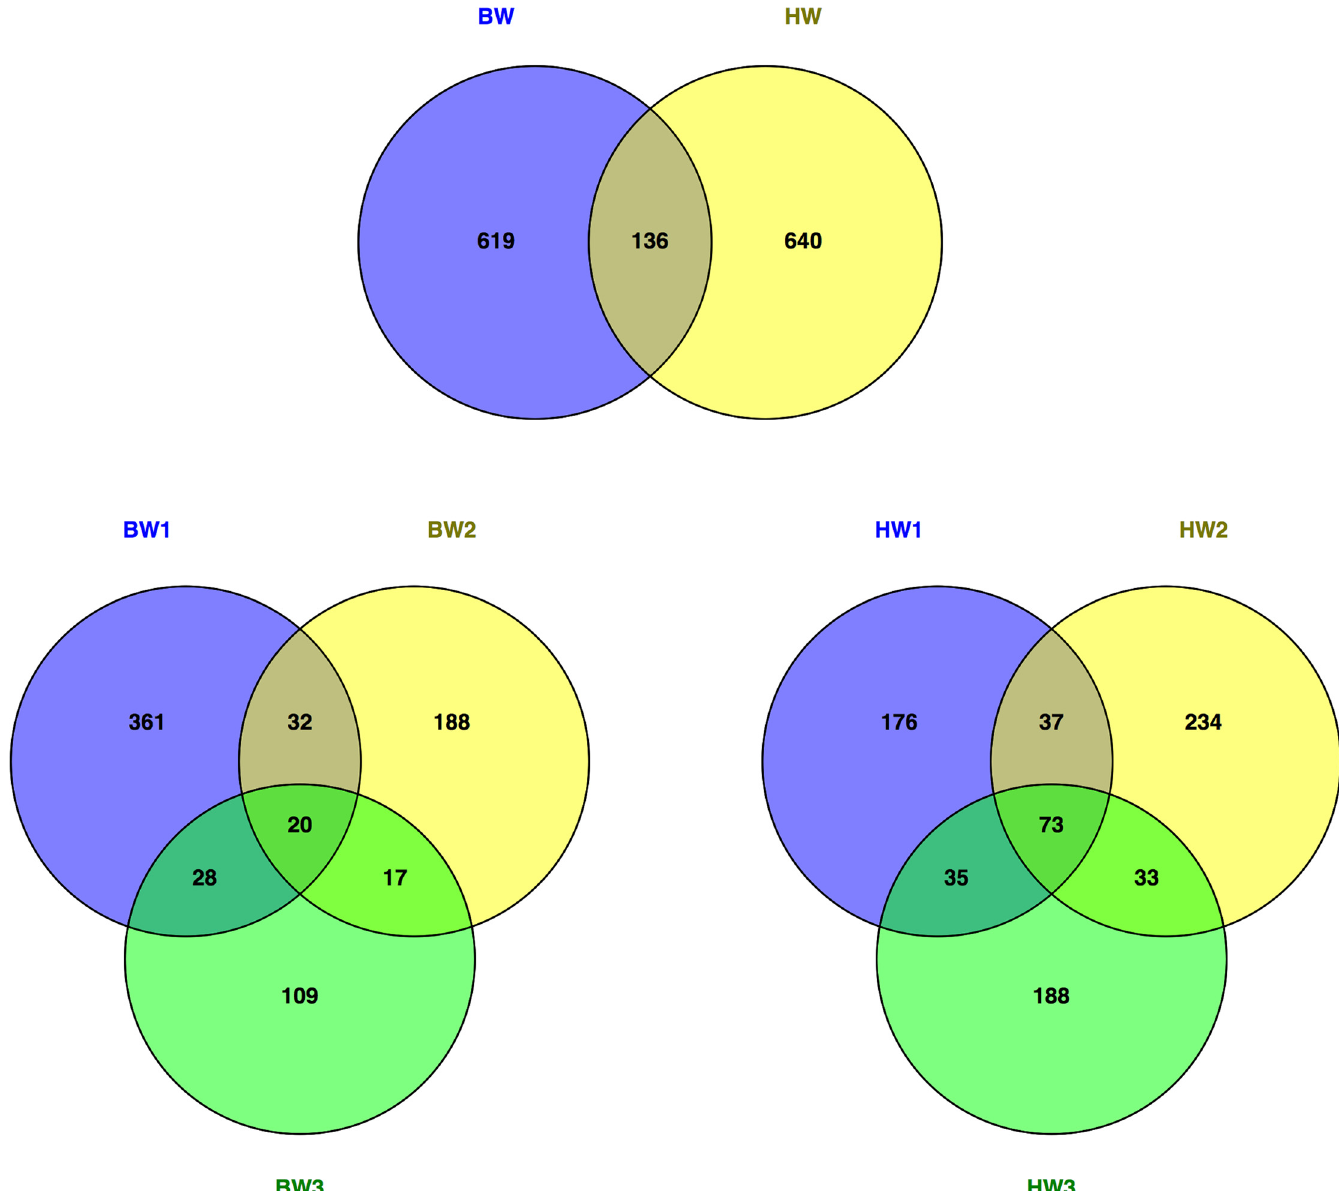
Fig 2. Total OTUs identified in ballast (BW) and harbor waters (HW) from community sequencing analysis.